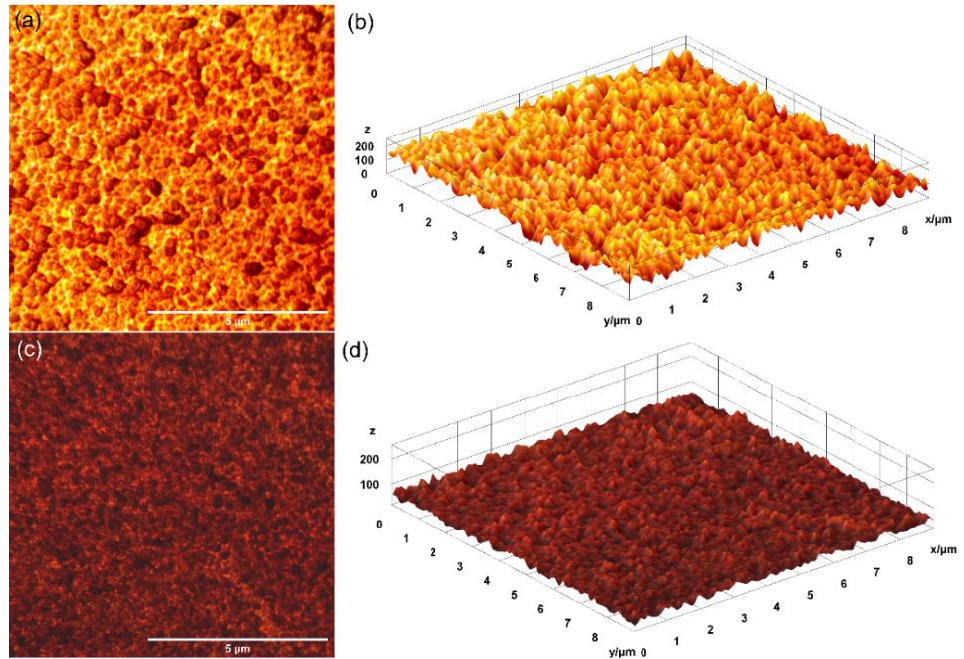
Figure 8. Metallographic microscopy image of the 5CeHAp-D ( a ) and 10CeHAp-D ( c ) composite thin films and their 3D representation ( b , d